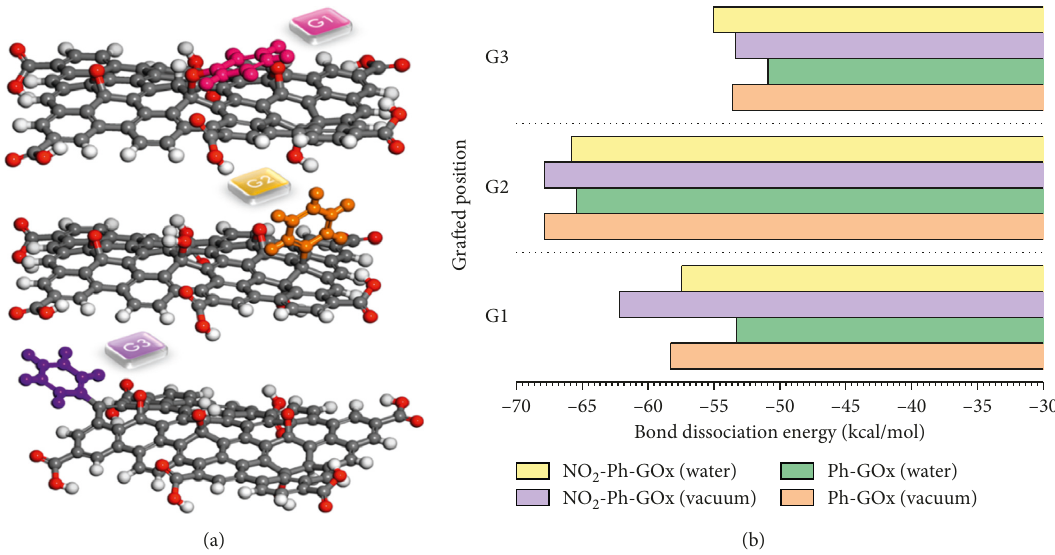
Figure 3: (a) Grafting positions (G1–G3) and (b) computed BDEs in vacuum and water (COSMO) for the bonding of phenyl radicals and nitrophenyl radicals at 3 distinctive grafting positions onto the GOx